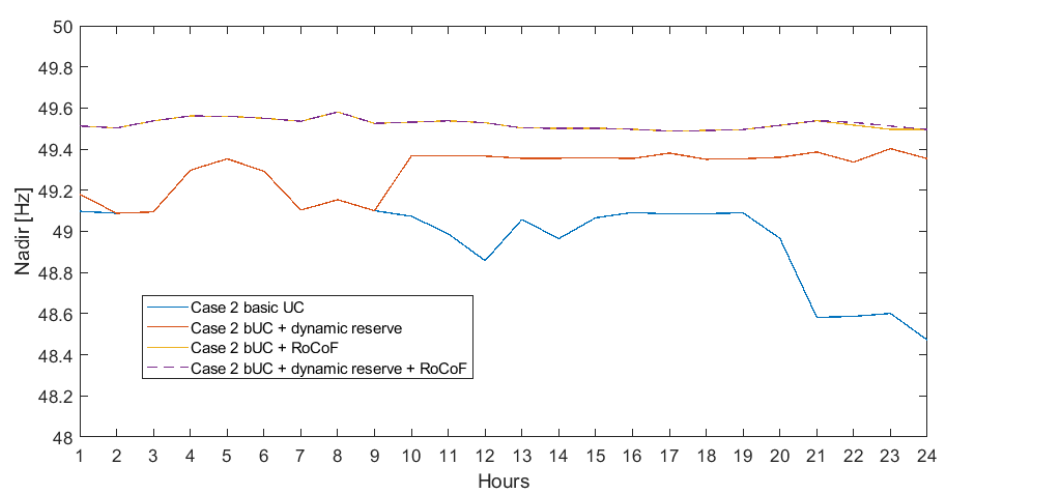
Figure 8. 24-h Case 2 nadir under various